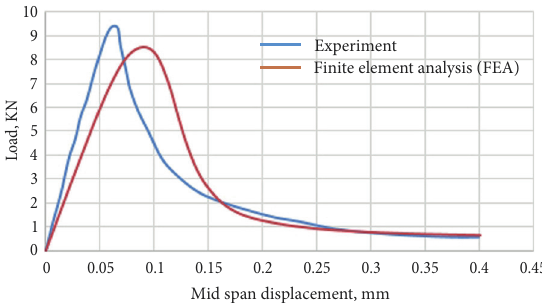
Fig. 23. Comparison load-displacement response: experimental (Le Bellego et al. 2003) and finite element analysis (FEA) in three-point notch beam with medium size